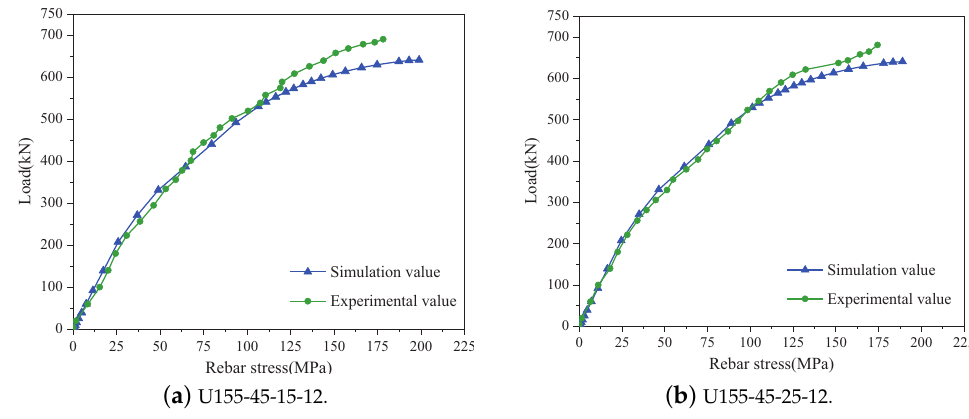
( b ) U155-45-25-12.